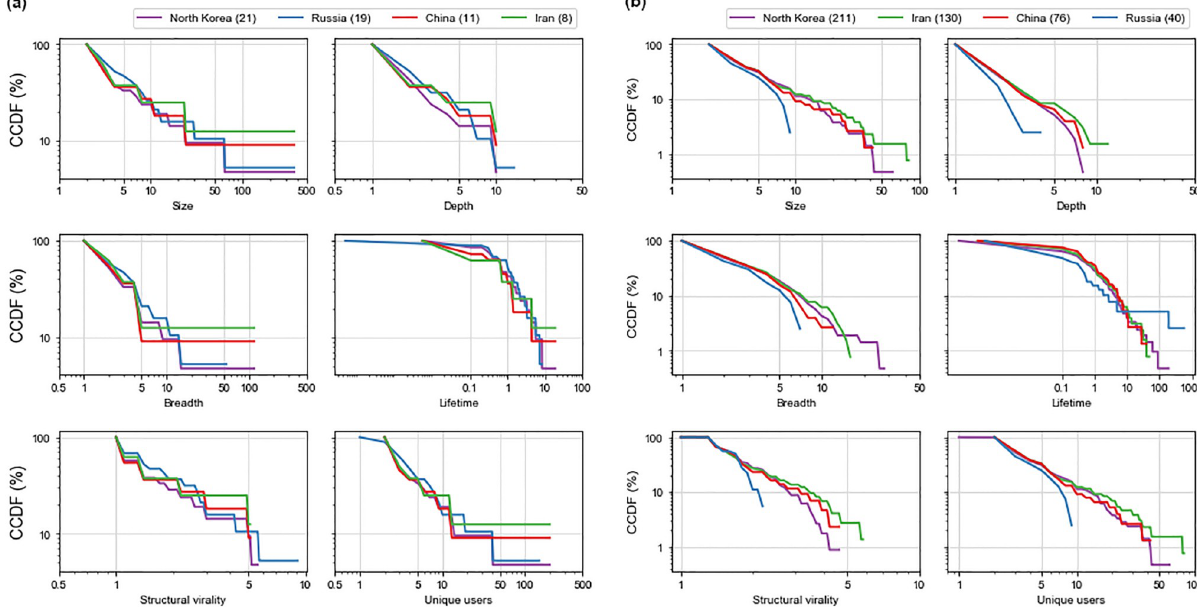
Fig 10. CCDF plots of information spread measurements on Reddit and Twitter for a subset of vulnerabilities exploited by different APT groups. (a) Reddit (b) Twitter.